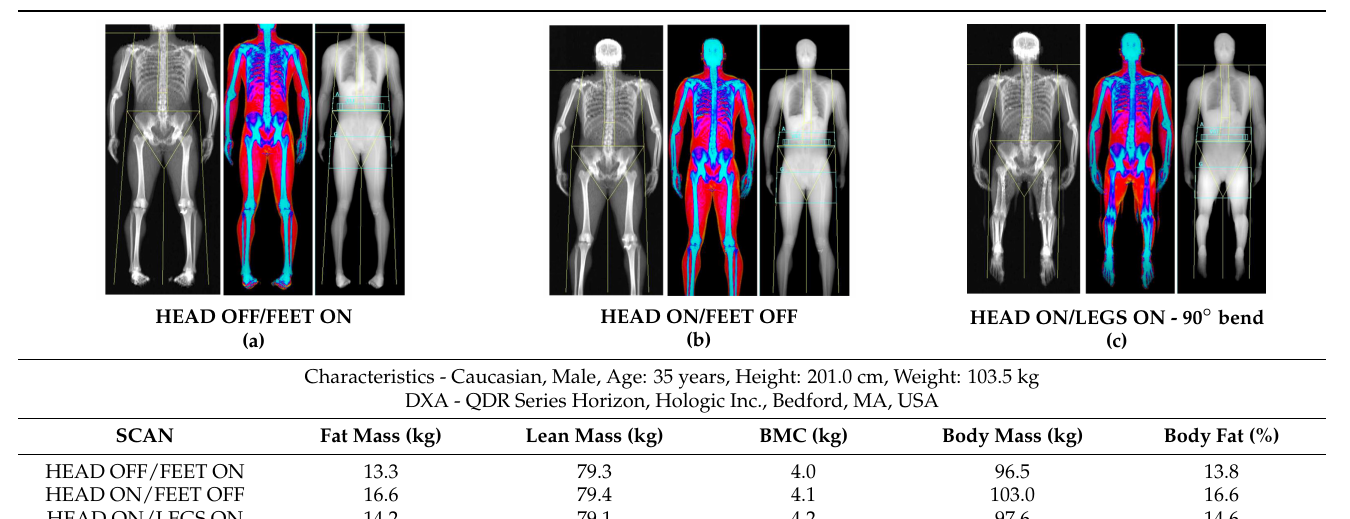
All measurements collected one after the other by one of the research team. dual-energy X-ray absorptiometry (DXA); bone mineral content